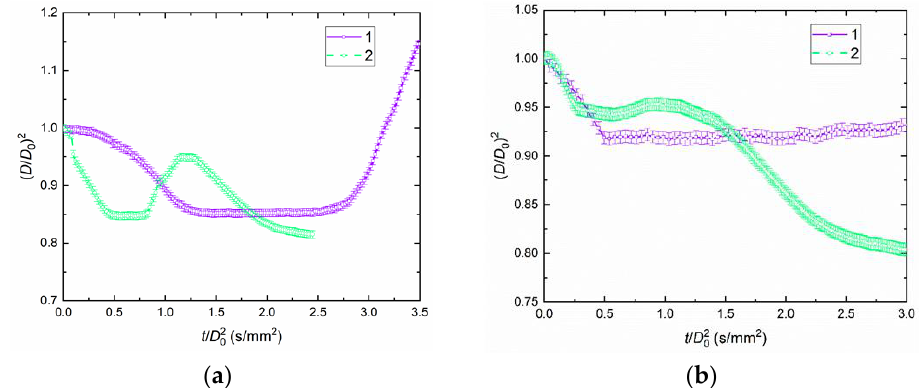
Figure 8. Temporal characteristics of droplet evaporation and drying until breakup for blends C50W49LE1 ( a ) and C50W50 ( b ) ( R d0 = 1.3 ± 0.1 mm): 1 — T a = 450 ± 30 K; 2 — T a = 950 ± 30 K.